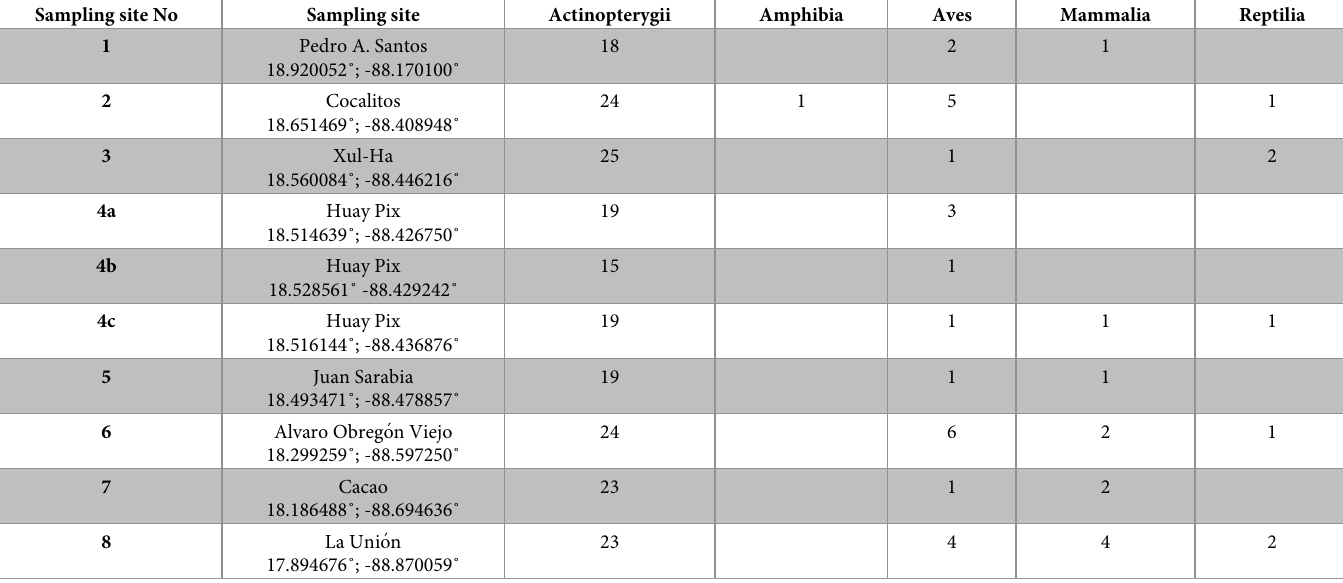
Table 4. Number of vertebrate species detected at each of the eight sampling sites. Sampling site No Sampling